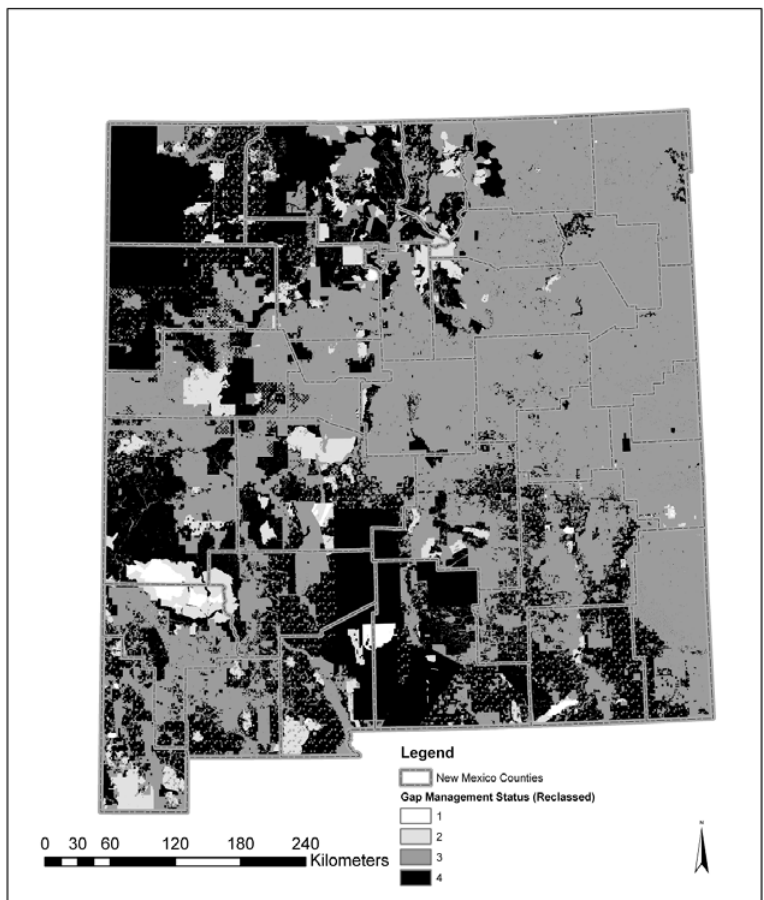
Figure 1. Reclassed Gap Management Categories for New Mexico for spatial